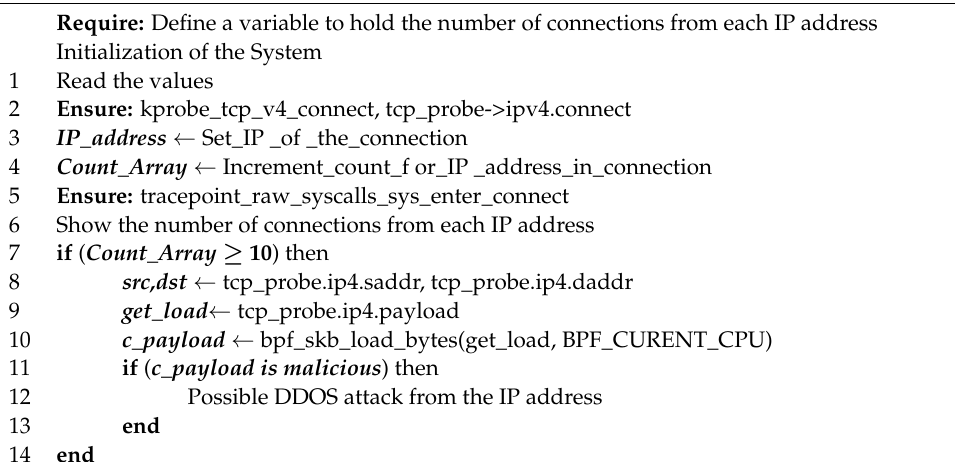
Algorithm 1: Detection of the attack